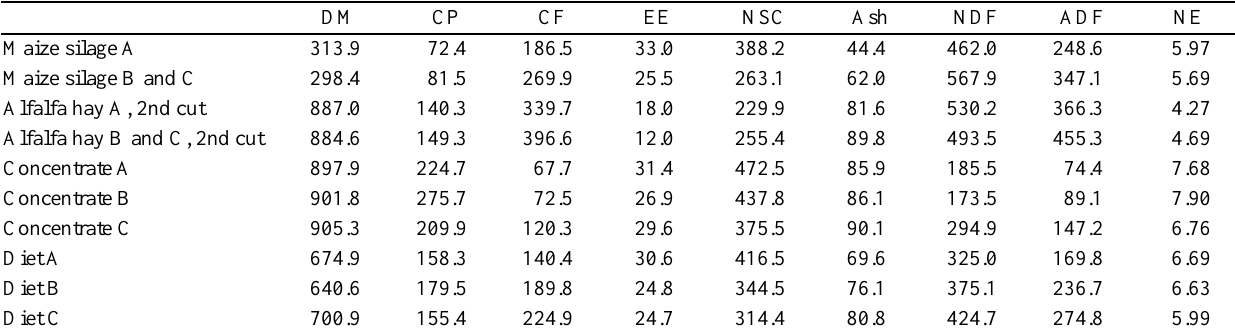
Table 1. Dry matter (g/kg as fed), chemical composition (g/kg DM) and net energy (MJ/kg DM) of feedstuffs utilized in experimental diets Maize silage A Alfalfa hay A, 2nd cut Alfalfa hay B and C, 2nd